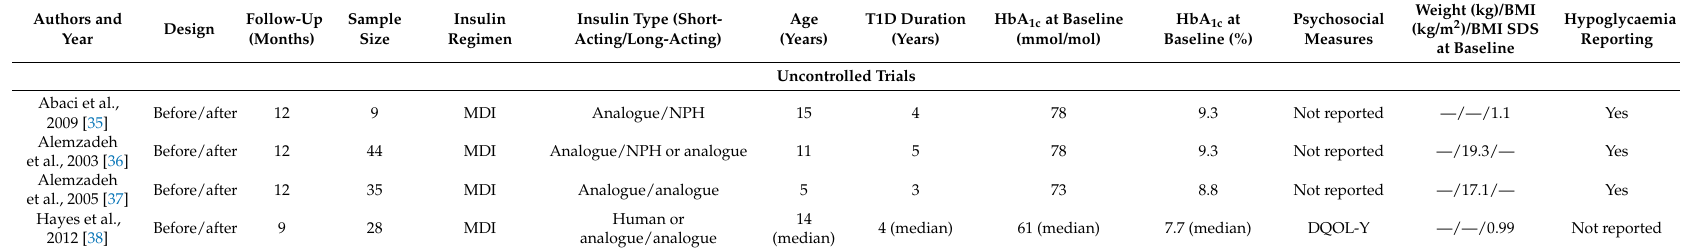
Table 1. Characteristics of uncontrolled studies with carbohydrate counting (CC) used in children and adolescents with type 1 diabetes (T1D). Authors and Year Design